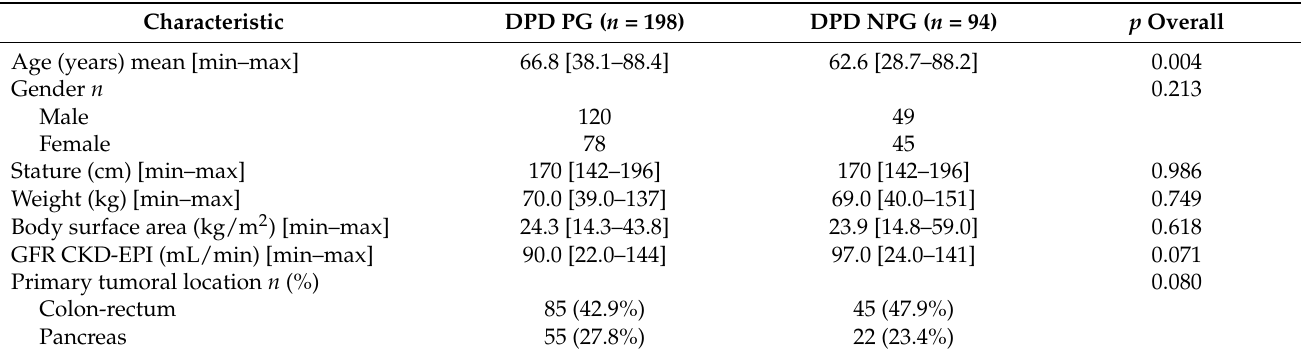
Table 1. Clinical characteristics of the